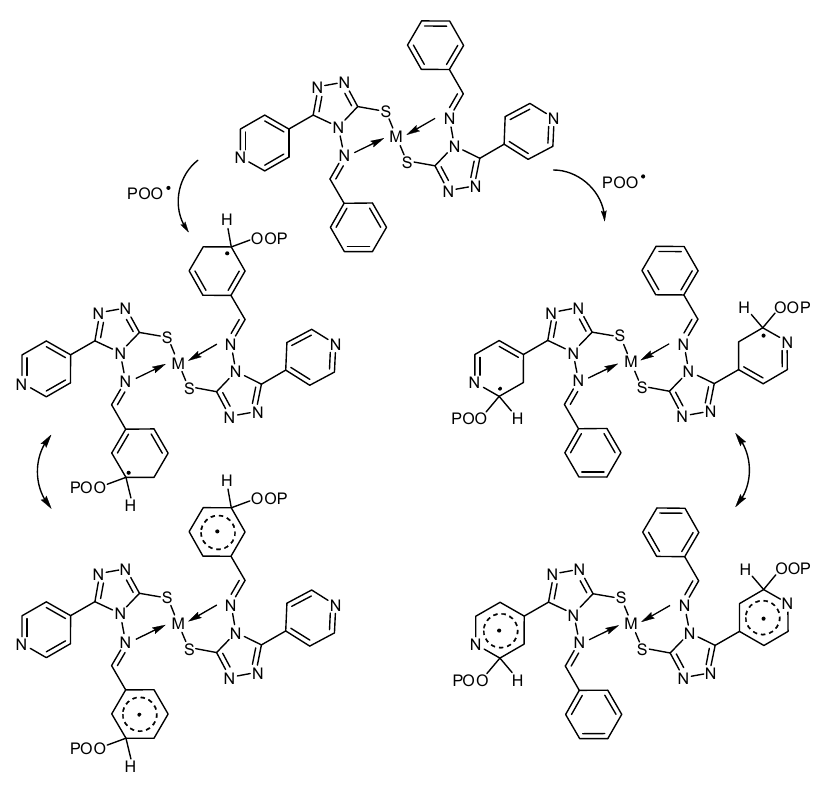
Scheme 4. Additives act as radical scavengers.